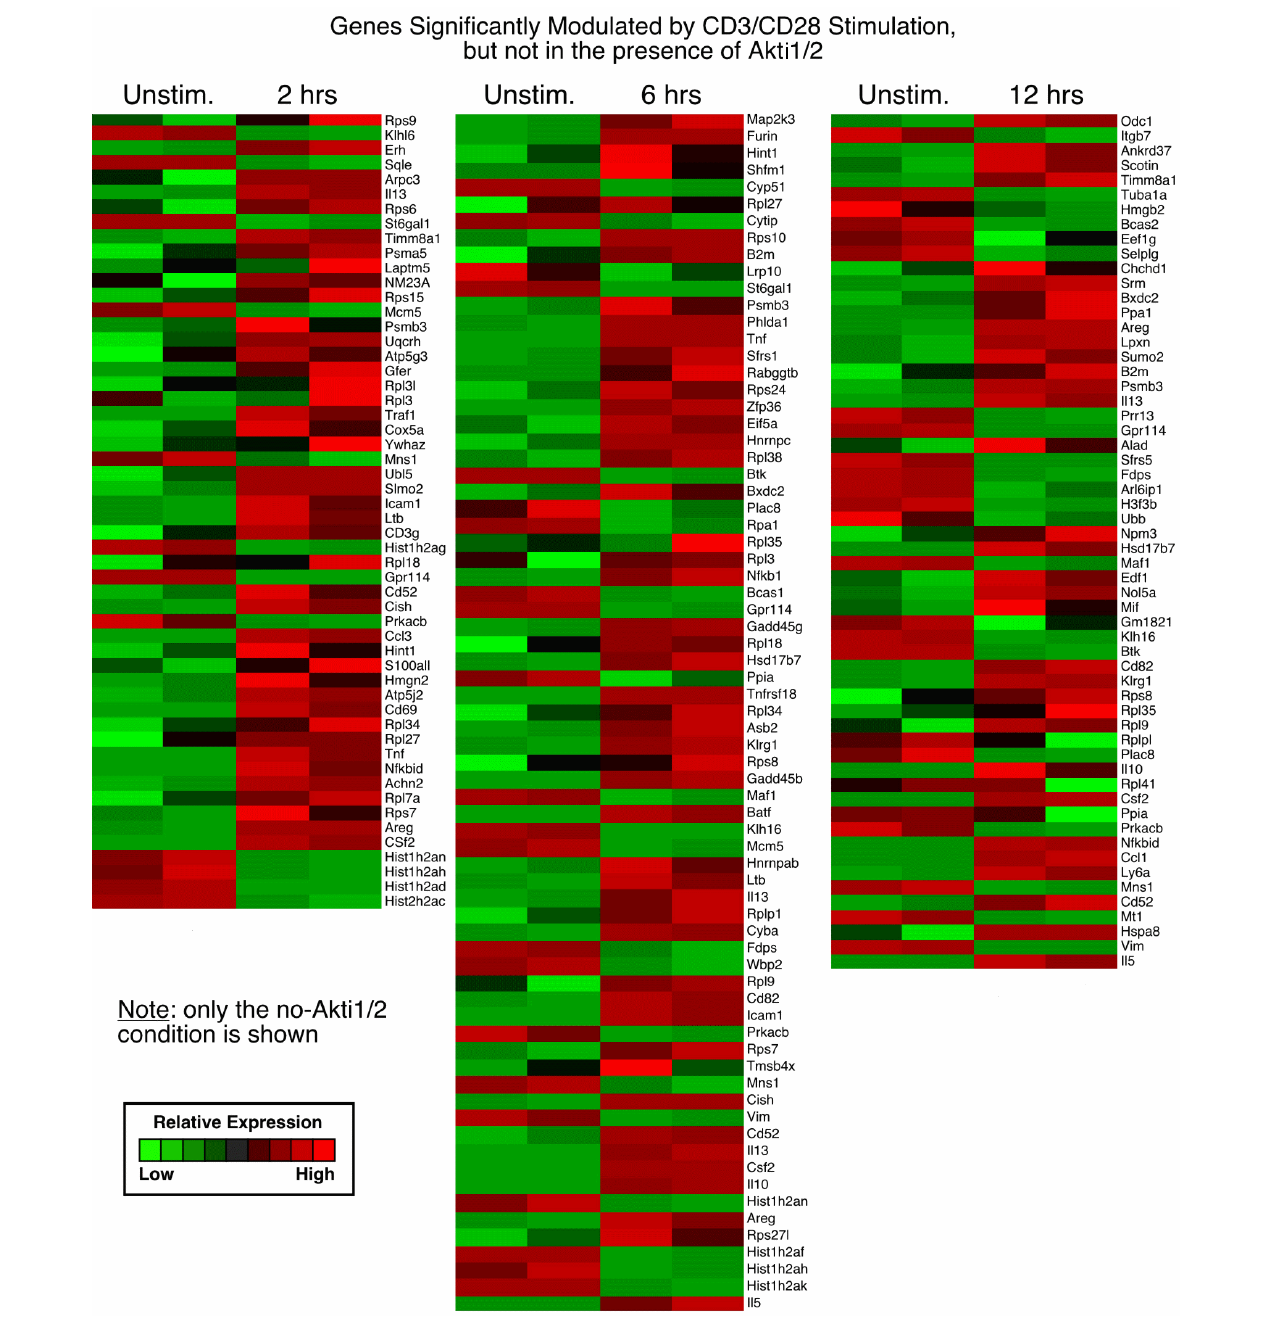
Supplementary Figure 1. Genes significantly modulated by CD3/CD28 stimulation alone, but not modulated in the presence of Akti1/2. Each row represents a gene and each column shows one of the duplicates from two different groups (from left to right 0 h vs. 2 h, 0 h vs. 6 h, 0 h vs. 12 h). The red and green colors reflect high and low expression levels,